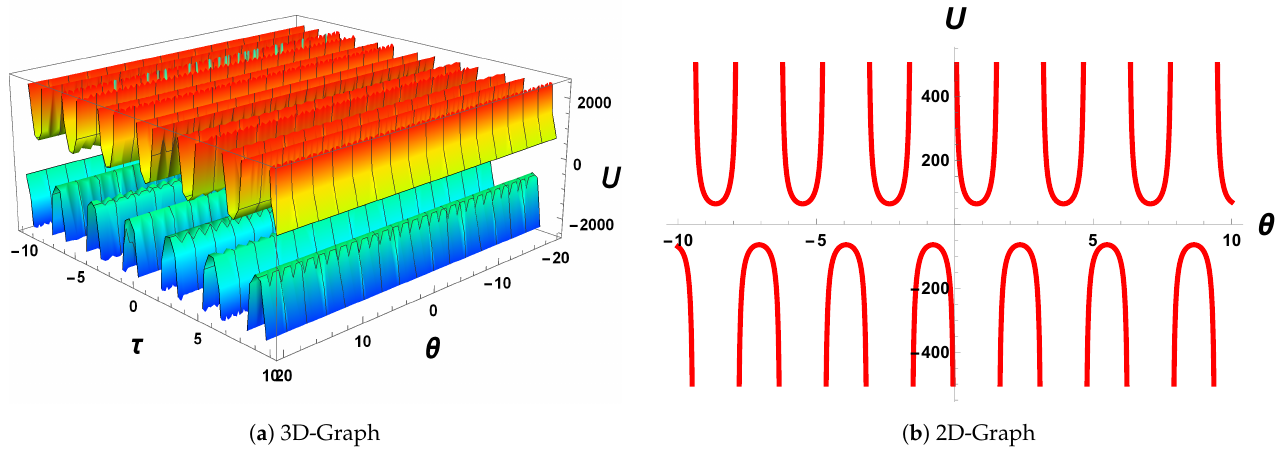
Figure 8. Diagrams a − 3 D and b − 2 D show graphically U 9 ( θ , τ ) for l 1 = 0.2, l 2 = 0.1, δ = 1.5, γ 1 = 0.5, γ 2 = 0.15, and γ 3 =